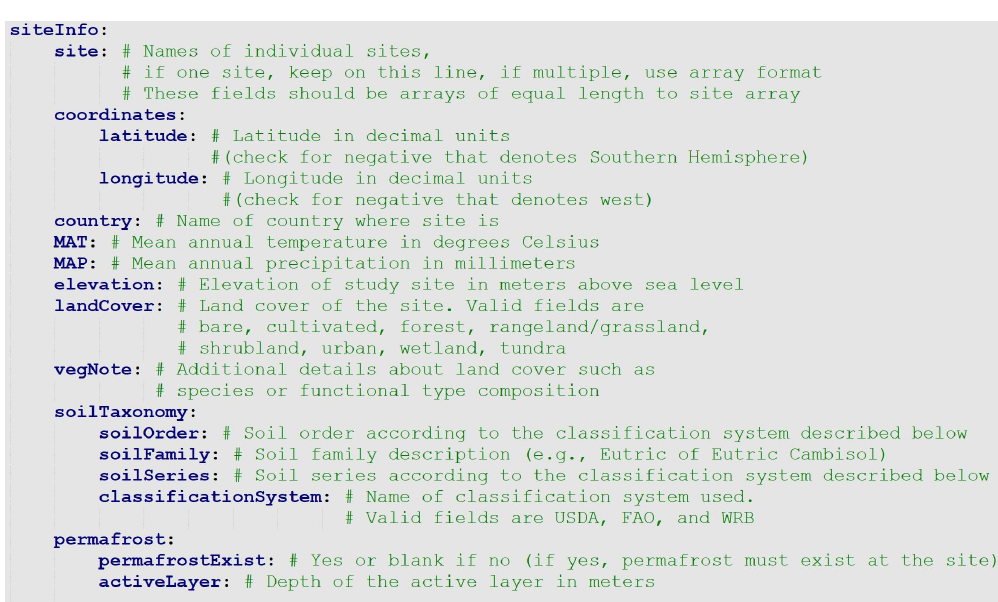
Figure 2. Bibliographic data needed for each database entry.